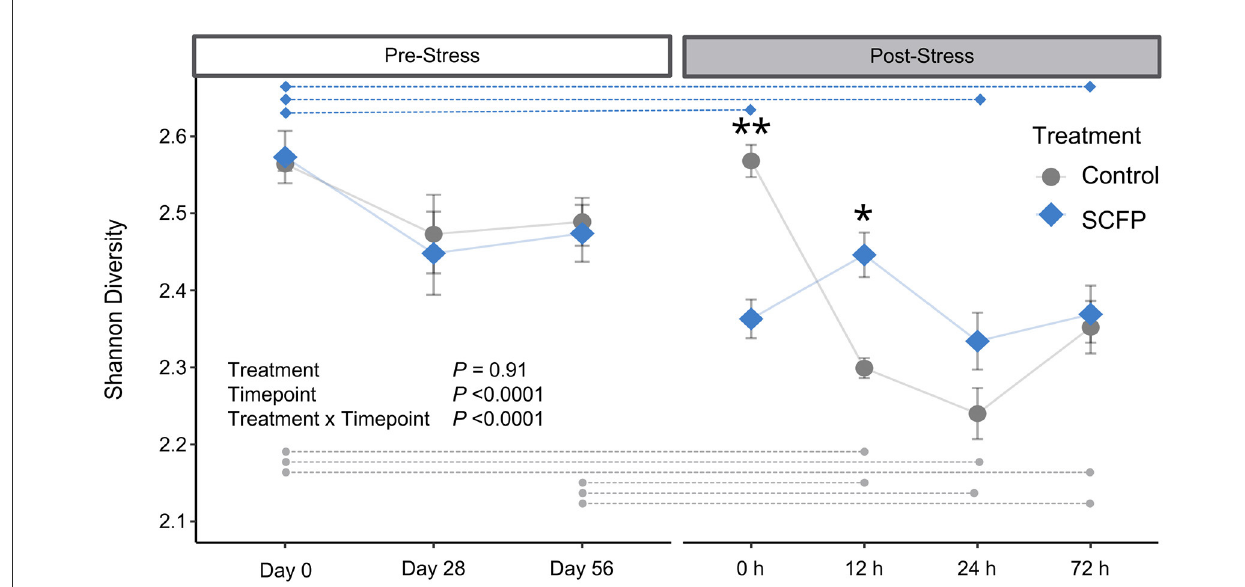
FIGURE2 Alpha diversity comparisons. Shannon diversity metrics were analyzed with a linear model which included horse as a random effect, treatment, timepoint, and their interactions. Raw means and standard deviations are shown in the plot. Blue diamonds represent SCFP, and gray circles represent Control. Transparent lines represent the hypothetical trajectory of diversity. Dashed horizontal lines represent within-group pairwise significant differences at the 0.05 level after Bonferroni multiple comparison adjustment. Asterisks indicate timepoints in which SCFP significantly differs from Control ** P < 0.01, * P <